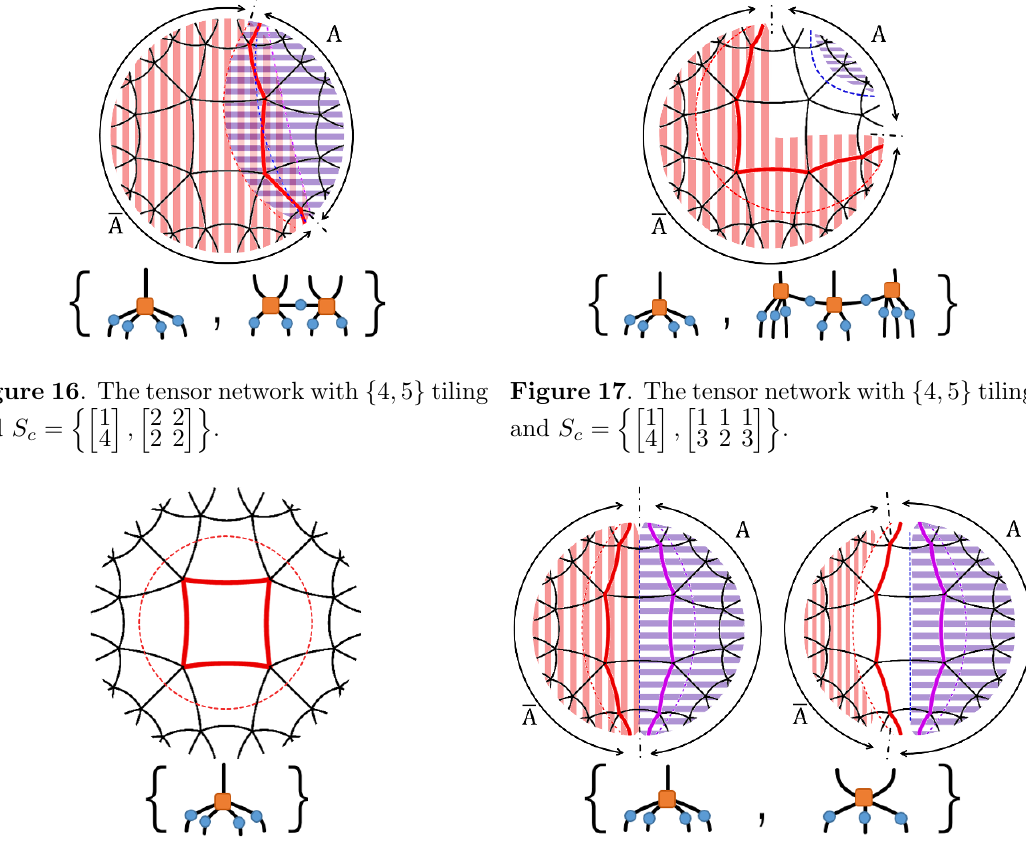
Figure 18 . The tensor network with f 4 ; 5 g tiling and S c =